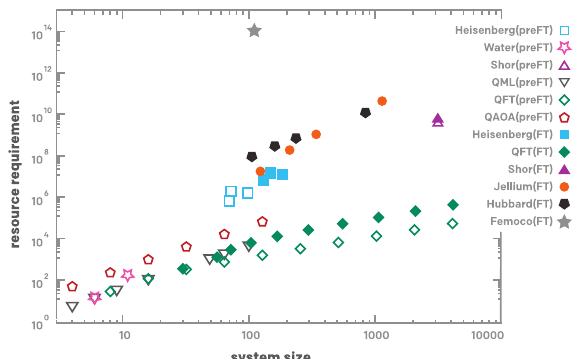
Fig. 1 Resource requirement of various quantum circuits as a function of system size. For the pre-FT regime, the resource cost is measured in terms of required number of XX gates. For the FT regime, the resource cost is measured in T gates, where each FT T gate requires tens of hardware-implementation-level XX gates 26,27 . Shown are the water-molecule ground-state computation (Water) 19 , Heisenberg-Hamiltonian simulation (Heisenberg) 5 , maximum-cut optimization (QAOA) 20 , the quantum Fourier transform (QFT) 21 , integer factoring (Shor) 22 , generative-model quantum machine learning (QML) 2 , Jellium- and Hubbard-model simulations (Jellium, Hubbard) 23 , and the Femoco simulation (Femoco) 4 . Grover ’ s algo- rithm 24 implementation (not shown) that solves known dif fi cult satis fi ability problems 25 requires ≳ 2000 qubits and ≳ 2 × 10 27 T gates. See Supplementary Note 1 for